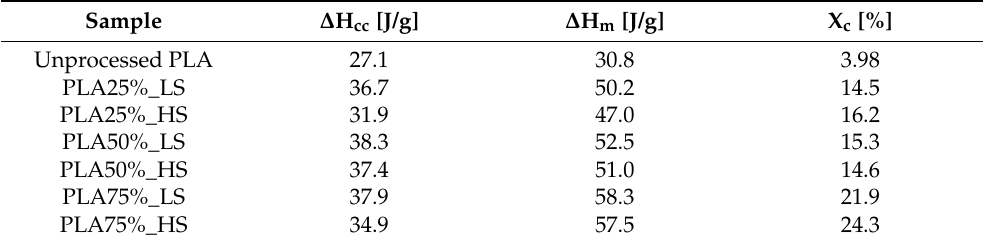
Figure 4. Viscosity ( a ) and DSC ( b – d ) curves for PLA material at different experimental temperatures. Table 4. Results of the DSC